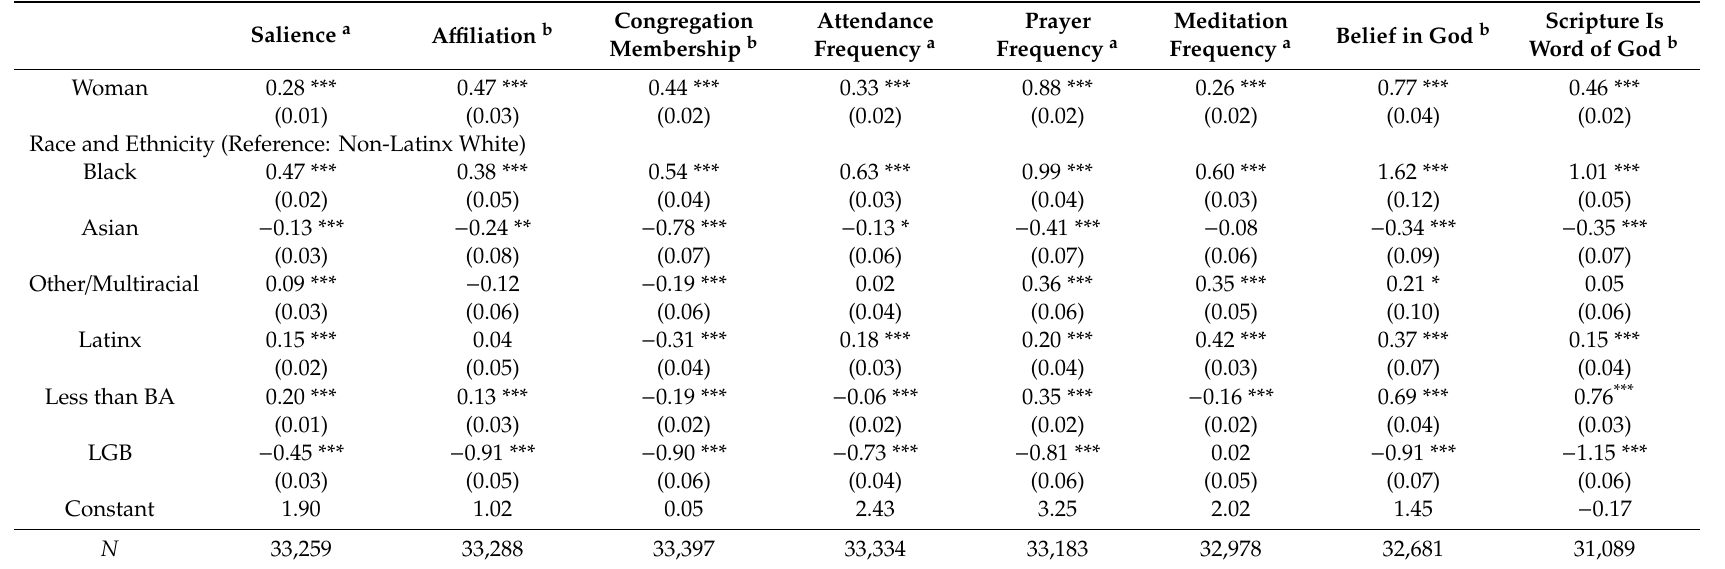
Table 3. Status characteristics and religious belonging, behaving, and